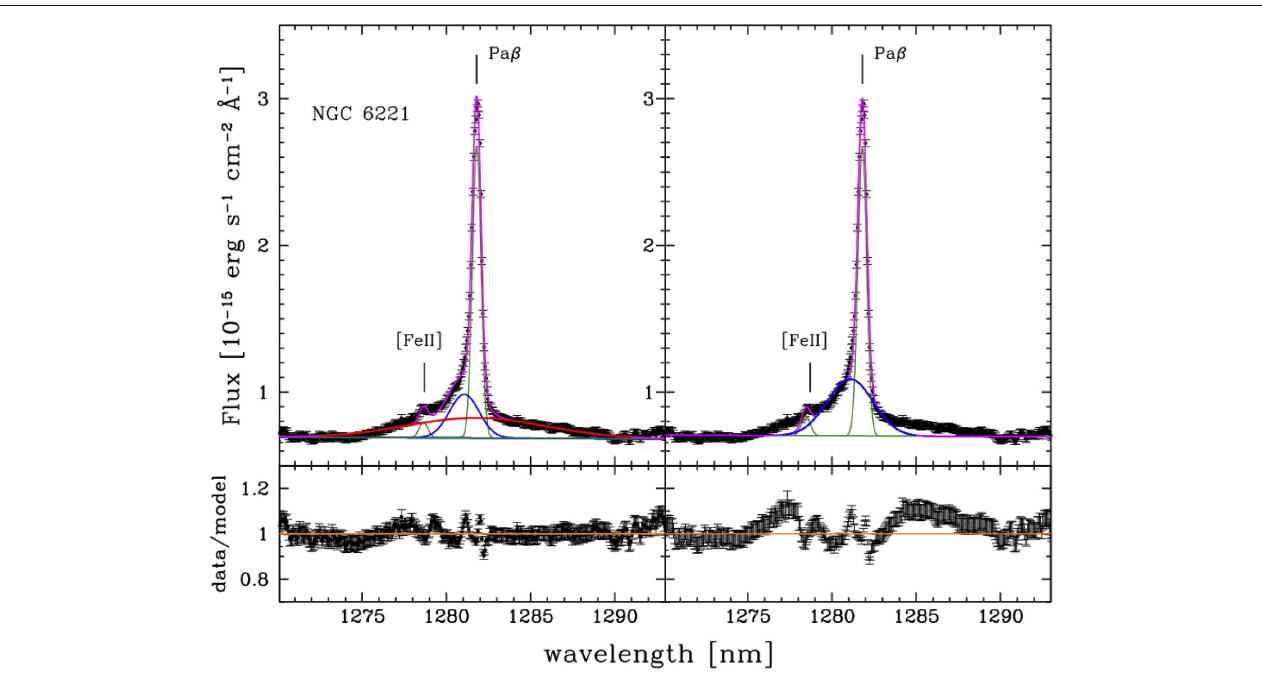
FIGURE 3 | Left: Best fit of the Pa β line of NGC 6221 including a broad (FWHM = 2257 km s − 1 ) component. Right : Same as before without including a broad Pa β component. The narrow, intermediate, and broad components are shown with green, blue, and red lines, respectively. Lower panels show the data to model ratio.